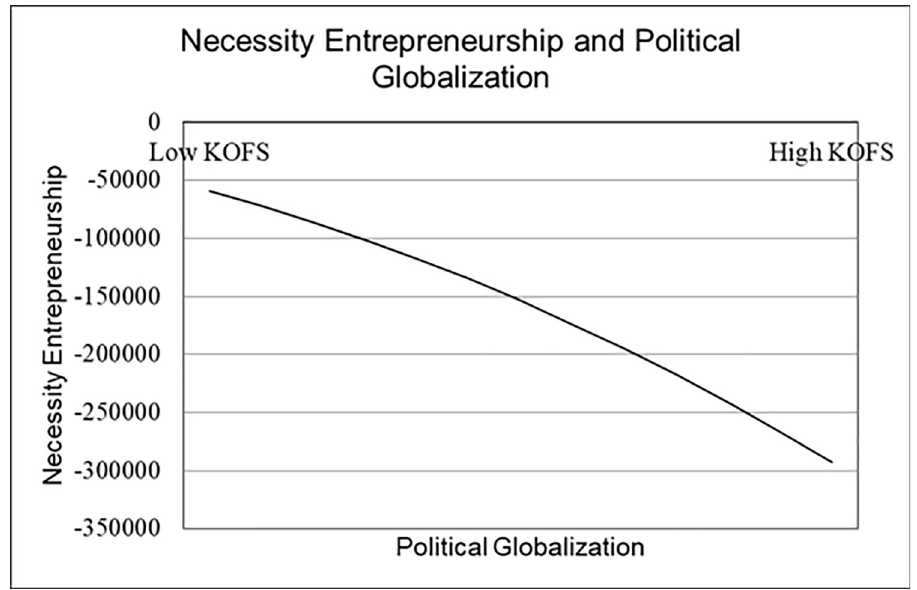
Fig 7. Quadratic fit of necessity entrepreneurship and political